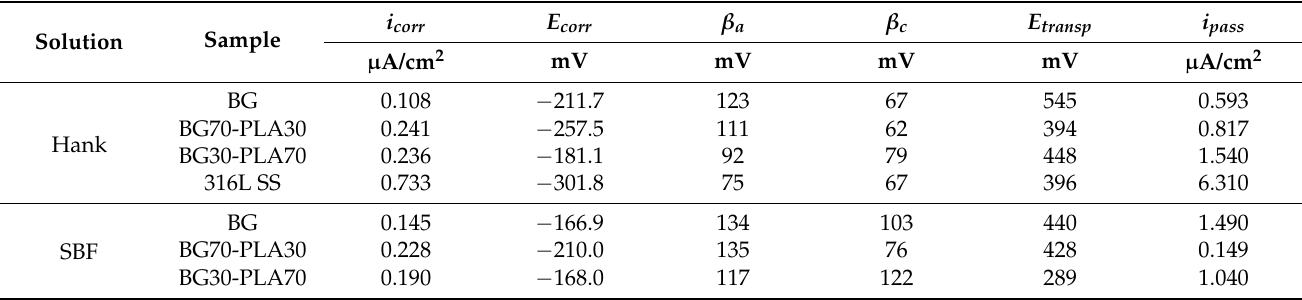
Table 7. Comparison of potential of corrosion between the samples evaluated in Hank’s and SBF